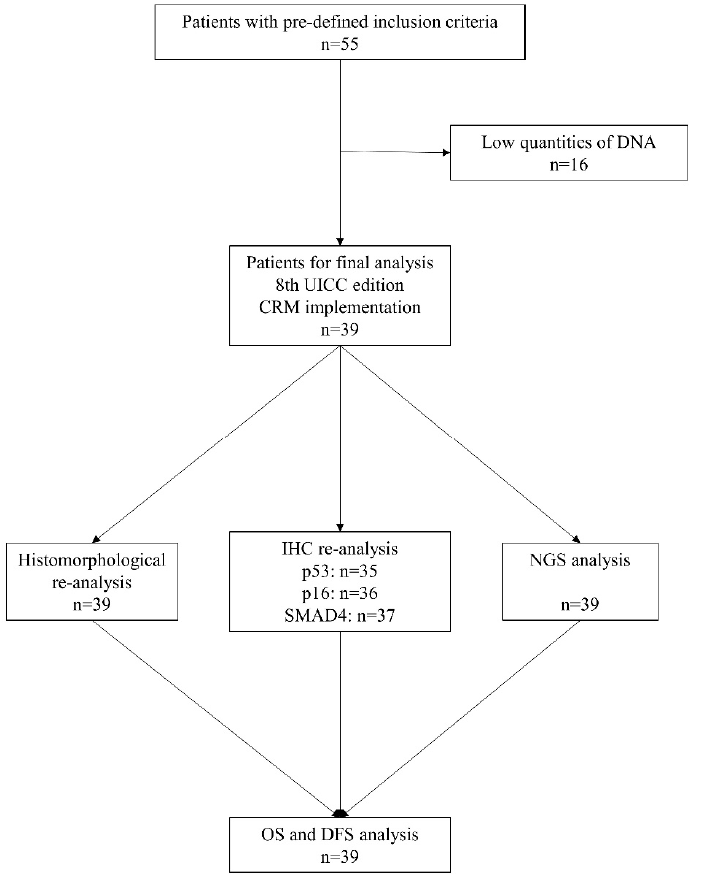
Figure 1. Flow chart of study cohort (CRM: circumferential resection margin; DFS: disease-free survival; IHC: immunohistochemical; NGS: next generation sequencing; OS: overall survival). The median age of all 39 patients at the time of surgery was 69 years (range: 47–90). Our cohort consisted of 24 male (61.5%) and 15 female (38.5%) patients. All patients re- ceived a partial pancreaticoduodenectomy. Thirty-three patients (84.62%) received gem- citabine monotherapy, while six patients (15.38%) received a combination therapy with paclitaxel. FOLFIRINOX as a standardized adjuvant treatment regime was not applied to our study cohort based on the guidelines at the time the study was performed. Follow-up